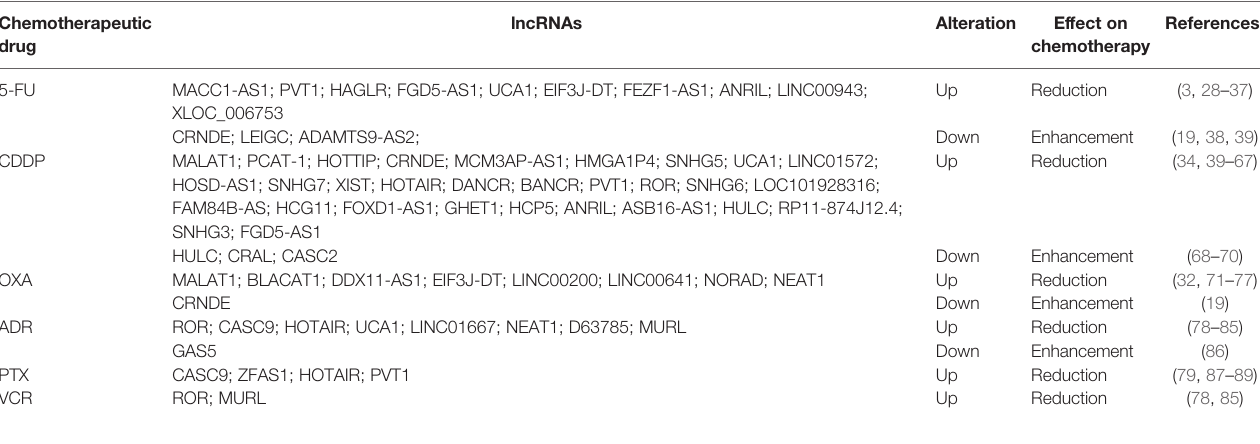
TABLE 1 | LncRNA and chemotherapeutic drugs in